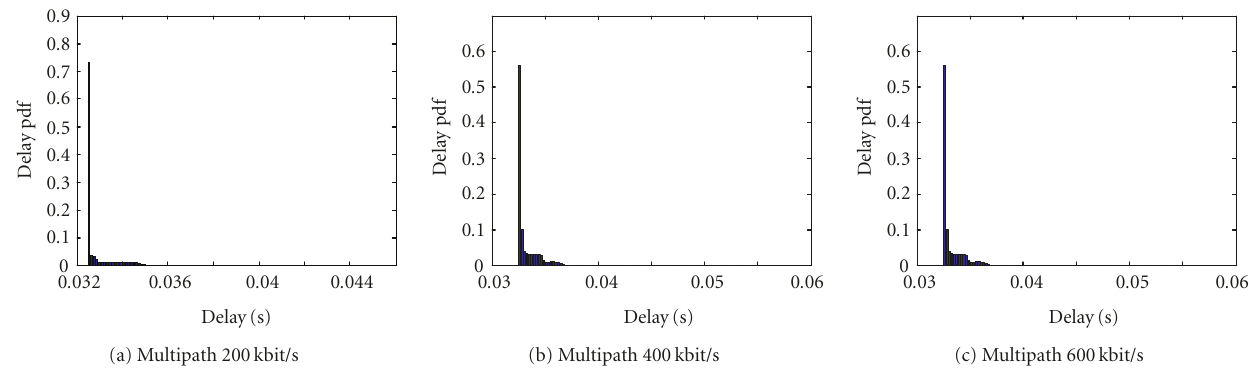
Figure 11: End-to-end delay distribution for multipath routing.